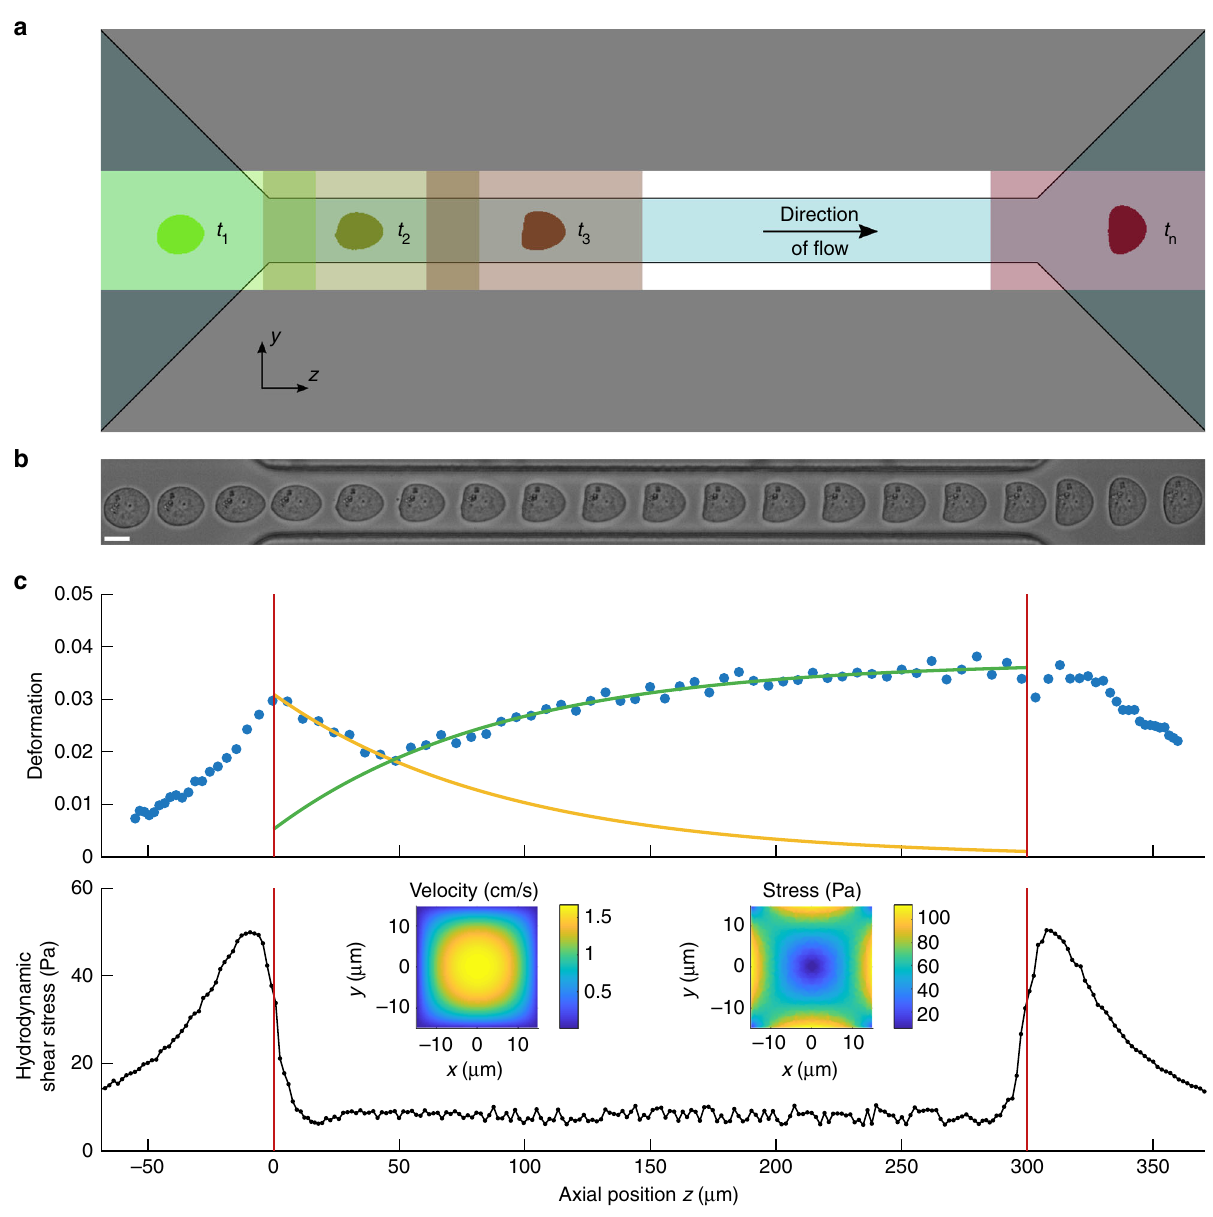
Fig. 1 Dynamic RT-DC. a Sketch of experimental setup showing micro fl uidic channel with translocating cell and corresponding region-of-interests at selected time points t 1 , t 2 , t 3 , and t n . b Time series of a suspended cell while translocating a 30 µ m × 30 µ m channel of 300 µ m length. Length of the scale bar is 10 μ m. c Deformation (1-circularity) trace of 92 single cell measurements along axial position z in the channel (blue dots). The yellow and green line originate from an exponential fi t characterizing two apparent cell relaxation modes (top). The red vertical lines indicate channel inlet and outlet position. Finite element method (FEM) calculations of hydrodynamic shear stress pro fi le along the same micro fl uidic channel axis at a fl ow rate of 8 nl s − 1 in the absence of cells (bottom). Insets show velocity and stress distribution of the channel